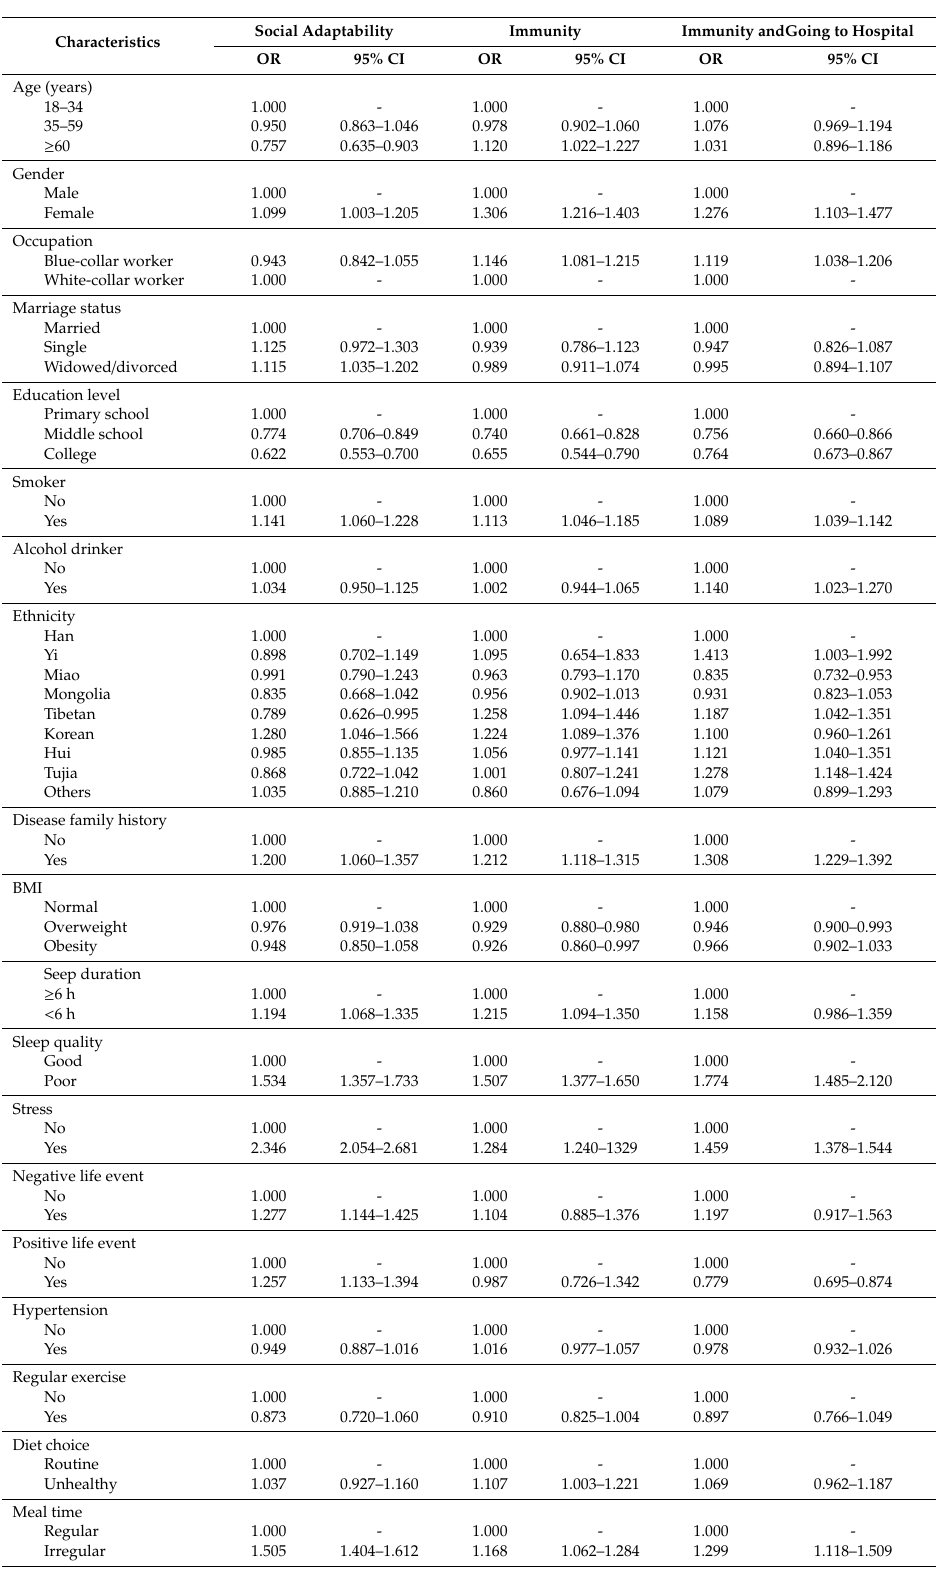
Table 5. Risk factors associated with each dimension of suboptimal health based on a multi-level multivariate GEE